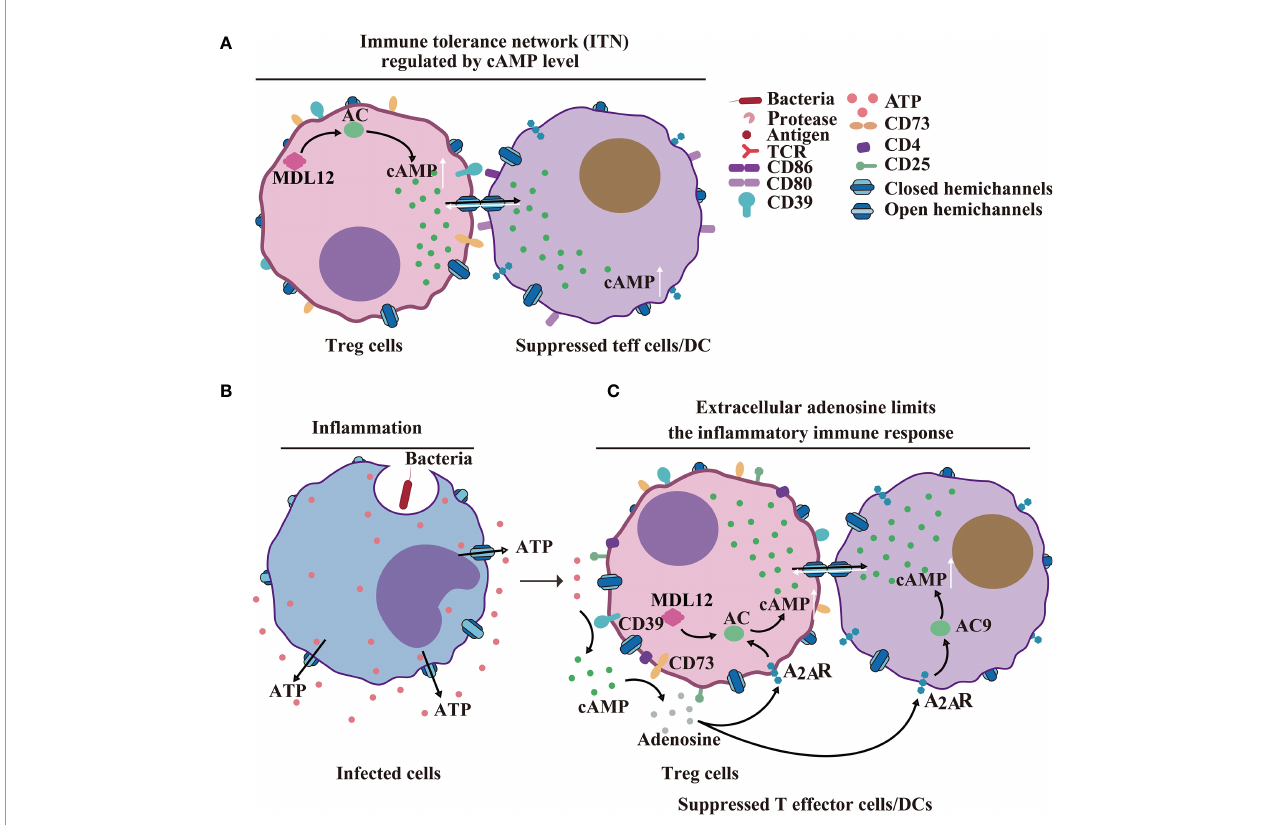
FIGURE 5 | HCs/GJs and IGLDCPs mediate adaptive immunity. (A) Cx43-cAMP cell-mediated immune response. Regulatory T cell-mediated inhibition of naturally occurring Treg cells and conventional T cells delivers cAMP to responder T cells via GJs to inhibit T-cell proliferation and IL-22 synthesis (89). (B) HCs in infected in fl ammatory cells release ATP. (C) Extracellular adenosine limits the extent of the in fl ammatory immune response. Activated CD4 + T cells. The activated CD39 + cells release cAMP via paracrine signaling, to suppress T effector (Teff) cell and dendritic cell (DC) functions (89). HC, hemichannel; IGLDCP, Ig-like domain-containing